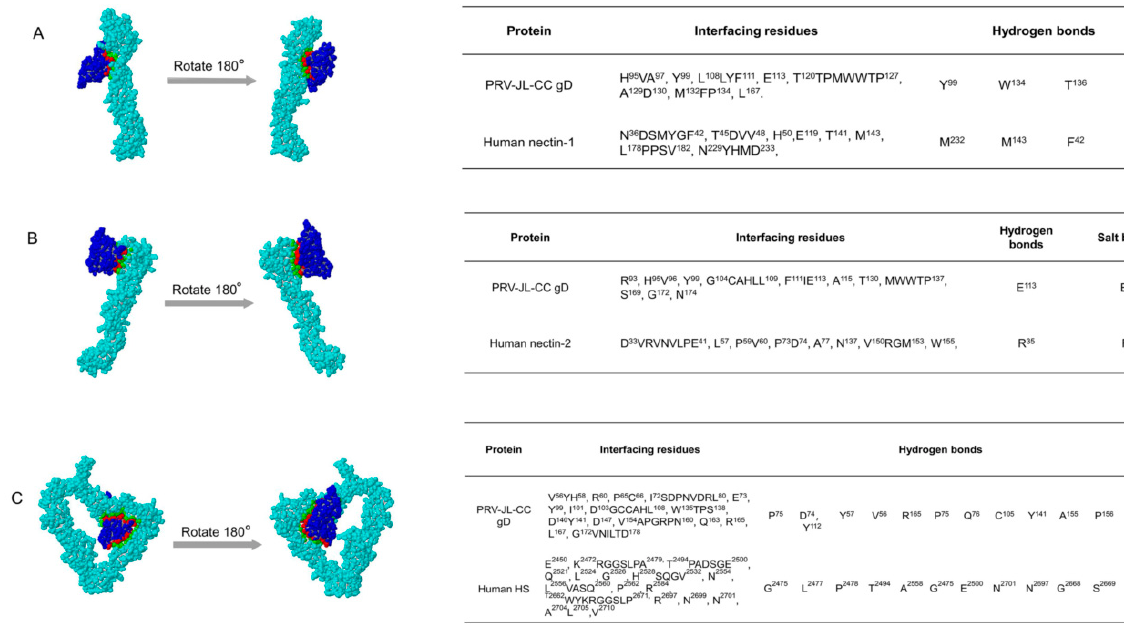
Figure 3. The structure and interface of PRV JL-CC gD with human nectin-1 ( A ), human nectin-2 ( B ) and human HS ( C ). The tables listed the interfacing residues and type of interaction. The gD protein of PRV JL-CC is marked in blue, and its binding site with nectin-1, nectin-2 and HS is marked with red; human nectin-1, nectin-2 and HS are marked with cyan, and its binding site with gD protein is labeled with green.